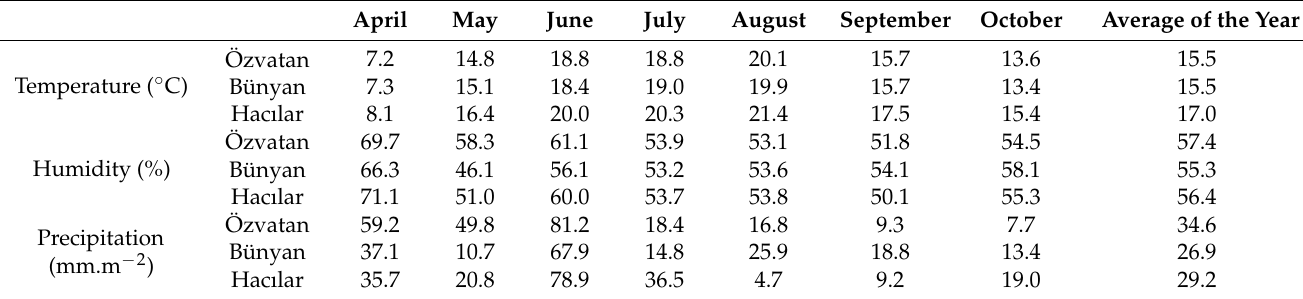
Table 2. Climatic data of the locations in the corresponding months of the study